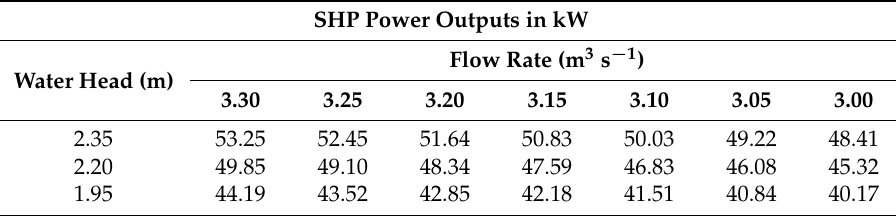
Table 1. SHP power outputs depending on changes in flow rate and water head.